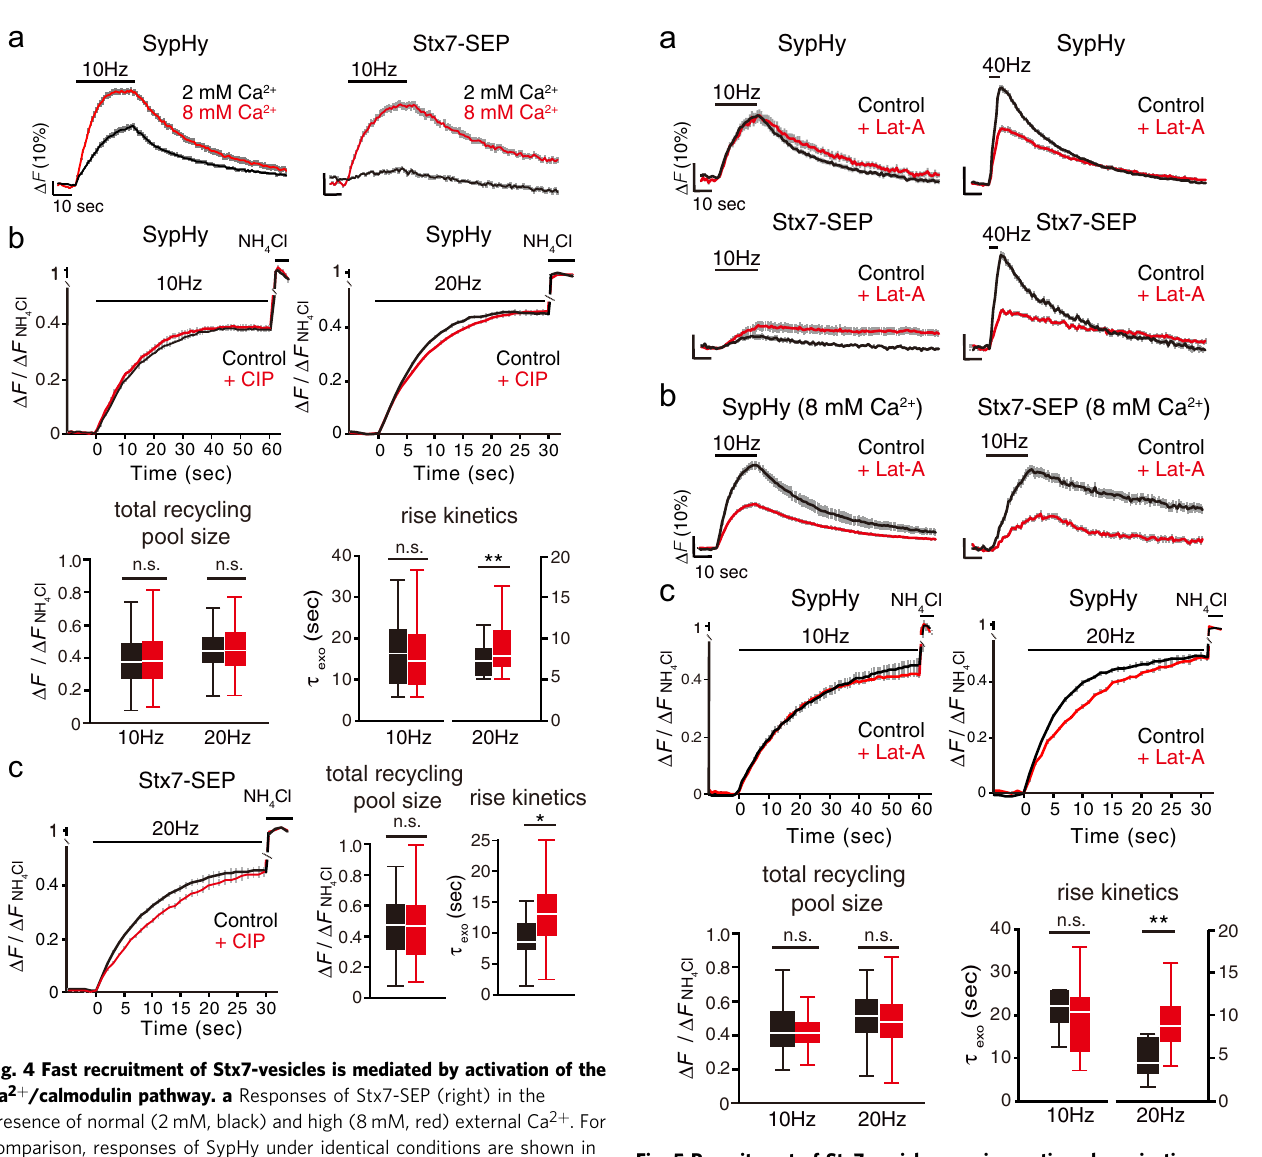
Fig. 5 Recruitment of Stx7-vesicles requires actin polymerization. a Effects of latrunculin A (Lat-A, 5 µ M; red) on responses of SypHy (upper traces) and of Stx7-SEP (lower traces) elicited by 10 Hz (left) and 40 Hz (right) stimulation. Control experiments without Lat-A in the respective conditions are shown in black. b Effects of Lat-A (red traces) on recycling of SypHy and Stx7-SEP in the presence of 8 mM external Ca 2 + . Control experiments without Lat-A in the respective conditions are shown in black. c Effects of Lat-A (red) on exocytosis of total recycling pool monitored by SypHy. Responses at 10 Hz, 600APs (left) and 20 Hz, 600APs (right) with ba fi lomycin treatment are shown. Control experiments without Lat-A in the respective conditions are shown in black. Bottom box-whisker plots show quantitative comparisons of total recycling pool sizes and rise kinetics. Normalized fl uorescence peaks (left) or the time constants of rise time ( τ exo ) (right) during the 10 Hz or 20 Hz stimulation are compared. All traces are average traces from 50 to 150